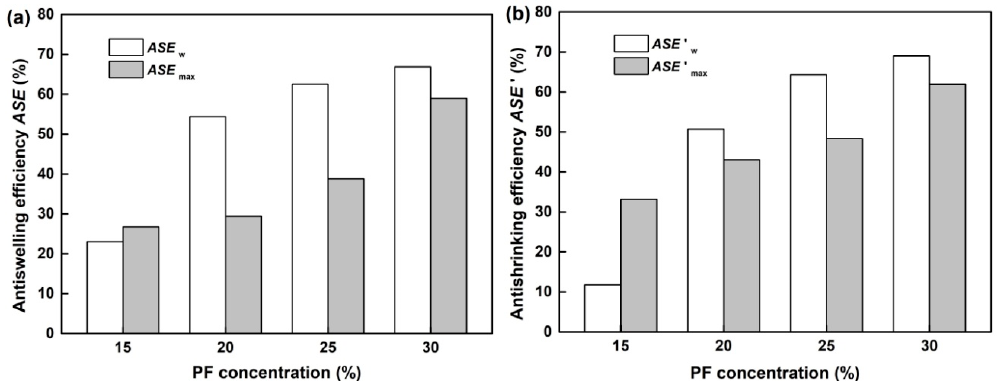
Figure 6. The anti-swelling and anti-shrinking efficiency of the modified wood: ( a ) anti-swelling efficiency; ( b ) anti-shrinking efficiency.